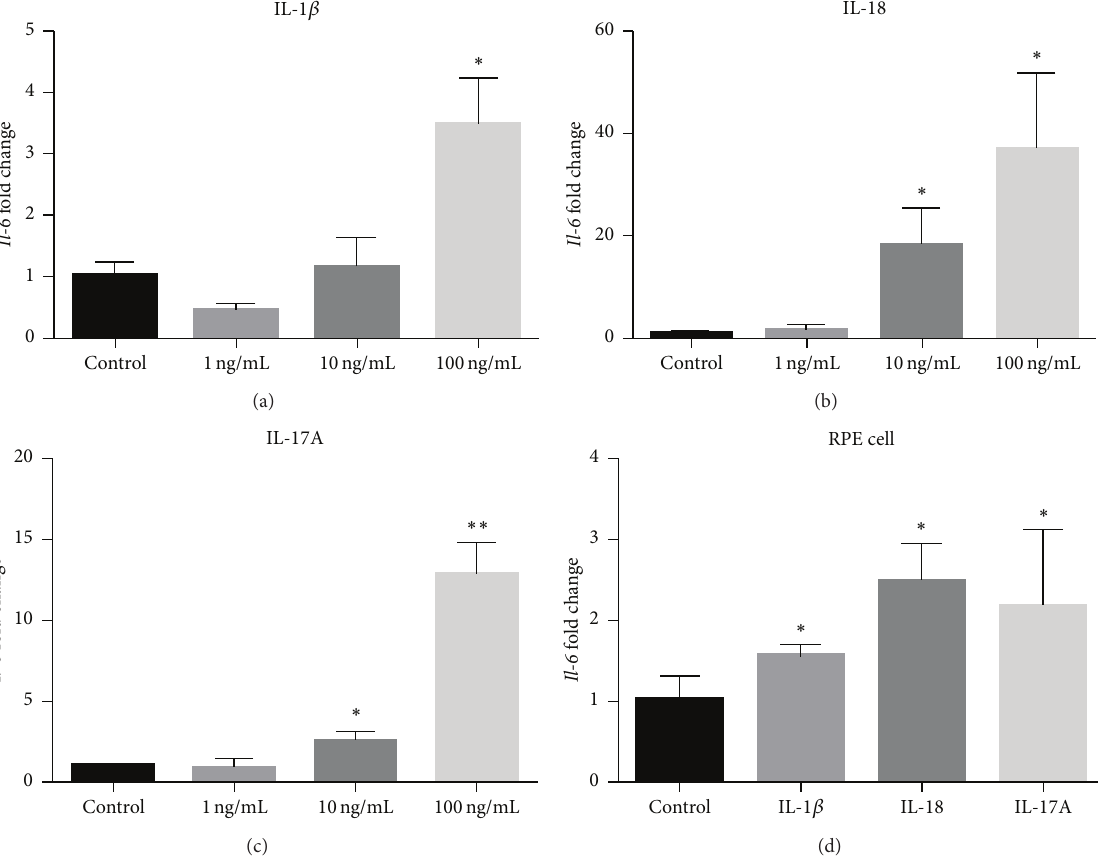
Figure 5: Proinflammatory effect of IL-1 𝛽 , IL-18, or IL-17A. Il-6 mRNA expression after stimulation with IL-1 𝛽 (a), IL-18 (b), or IL-17A (c) with different concentrations in RSCs. (d) Il-6 mRNA was induced after the stimulation of 100ng/mL IL-1 𝛽 , 10ng/mL IL-18, or 10ng/mL IL-17A in primary cultured mouse PRE cells. The mRNA levels of the Il-6 were measured by quantitative RT-PCR. ∗ 𝑝 < 0.05 ; ∗∗ 𝑝 < 0.01 compared to